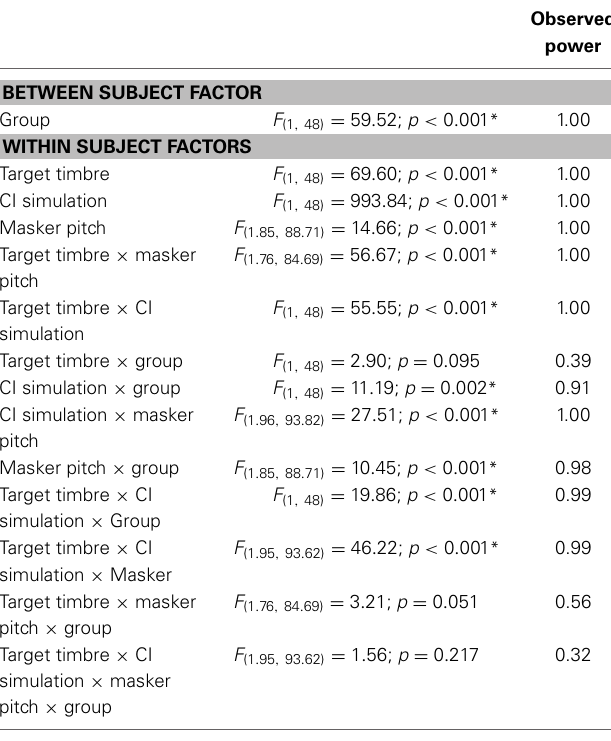
Table 5 | Experiment 3: Results from a split-plot RM ANOVA for melodic contour